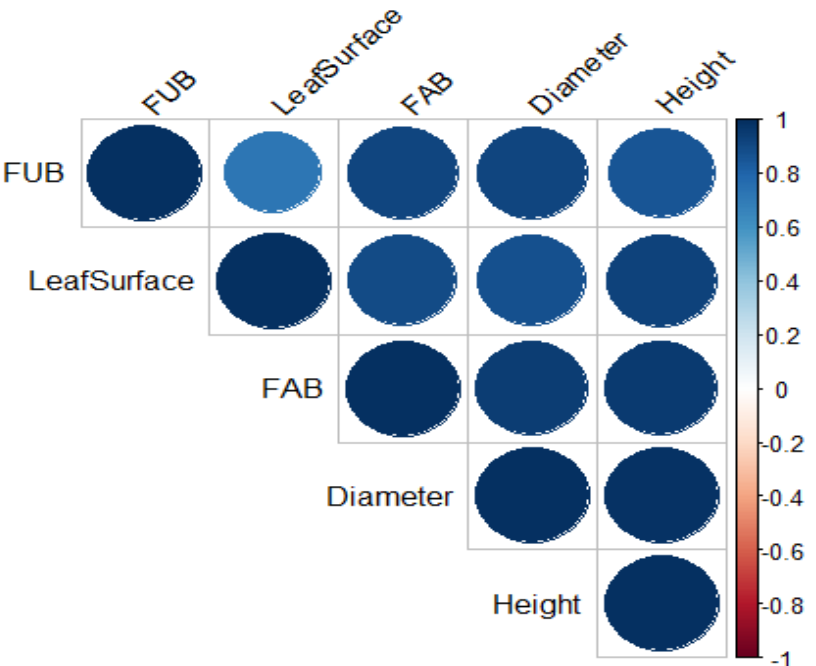
Figure 5. Correlation coefficients of the different parameters. FAB: fresh aerial biomass; FUB: fresh underground biomass.